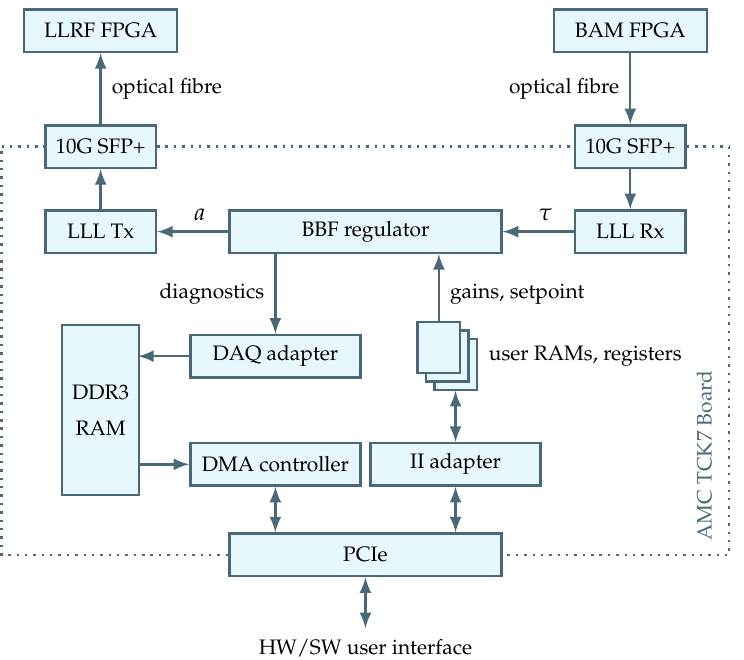
Figure 7. Beam-based feedback regulator in the context of MTCA.4 hardware